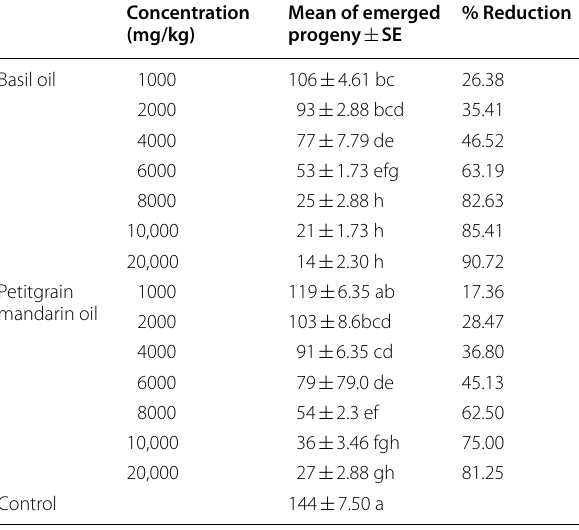
Table 3 Effect of basil oil and petitgrain mandarin oil on number of emerged progeny and reduction percentages of S. oryzae Concentration (mg/kg)